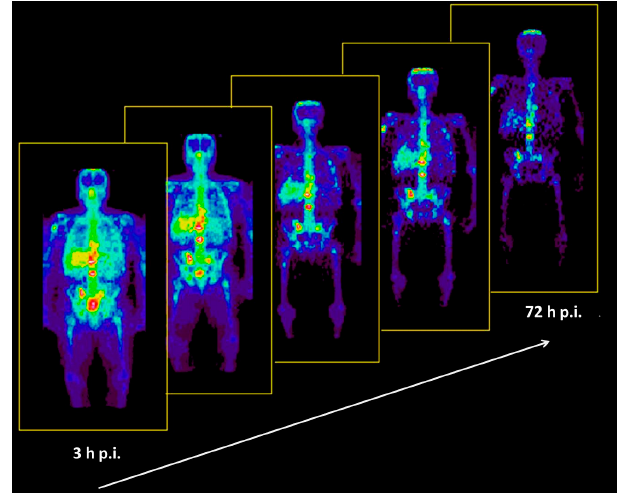
Figure 12. Whole-body distribution of 86 Y-citrate in a patient from 3–72 h p.i. The anterior view images are summations of all coronal slices.